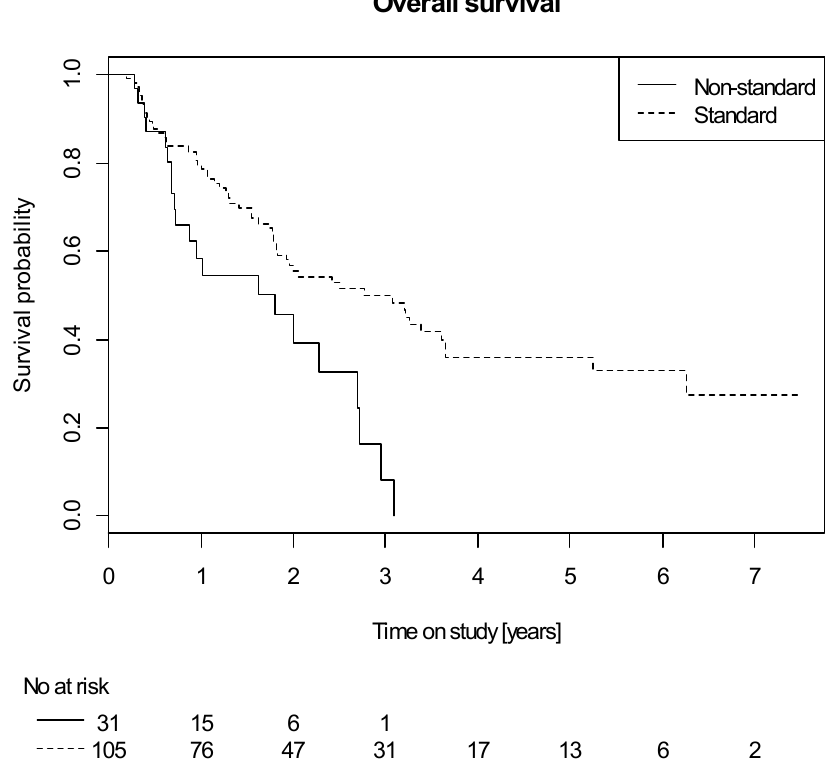
Figure 3. Overall survival of patients treated according to institutional standard vs. non-standard chemotherapy protocols .